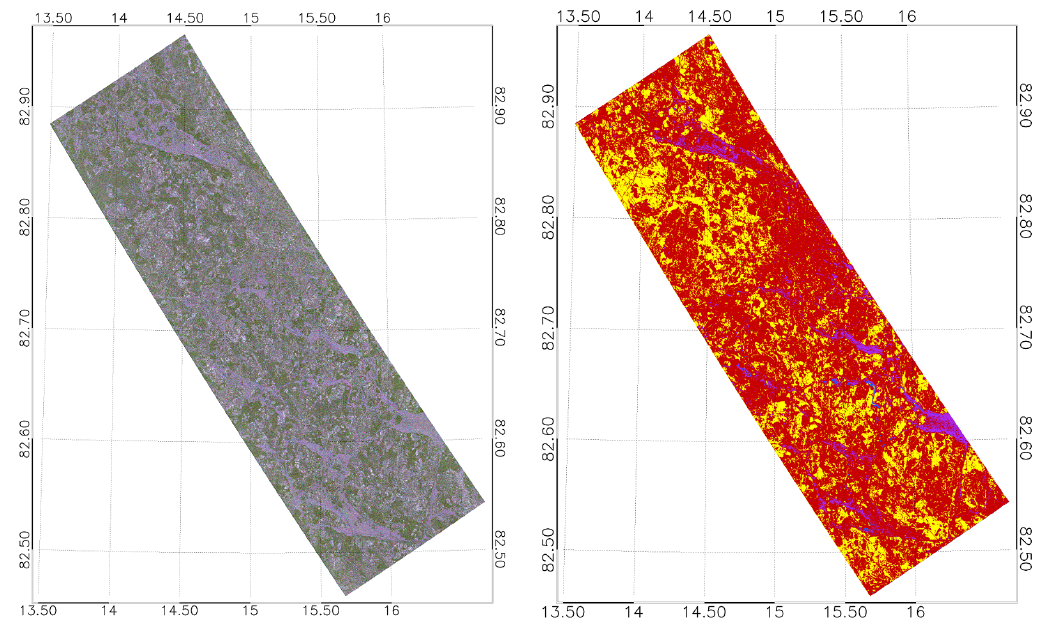
Figure A2. ( Left ) Geocoded Pauli RGB composite (Red: HH-VV Green: HV+VH Blue: HH+VV) of the TS-X acquisition on 19 April 2015, frame 2. ( Right ) ice classification. Blue: open water/nilas (OW), purple: young ice (YI), yellow: first year ice (SFYI), red: rough first year ice/multi-year ice (RFYMYI).